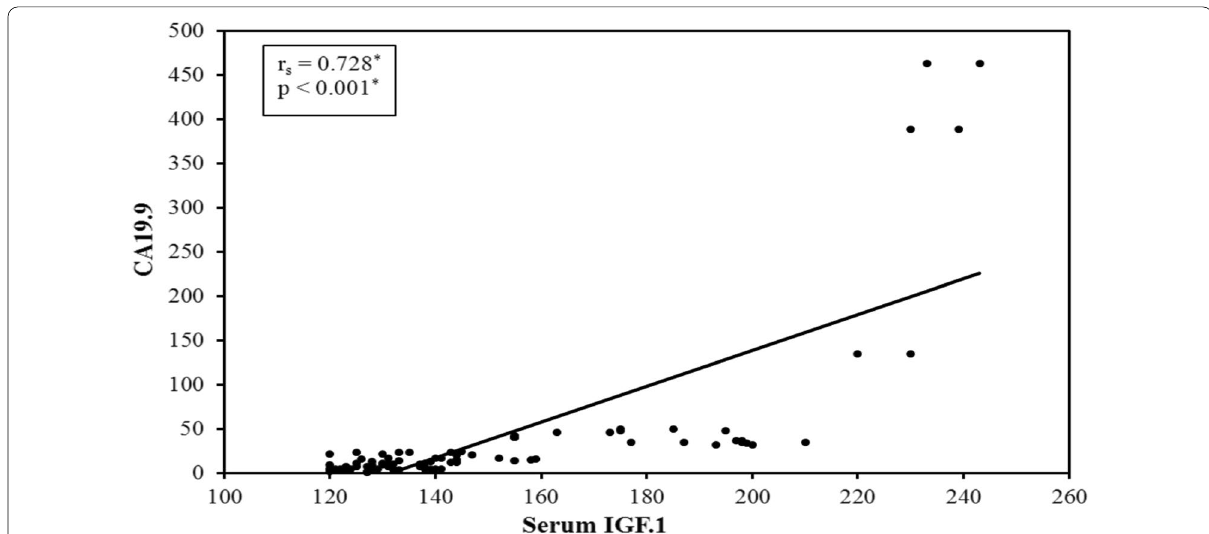
Fig. 5 Correlation between IGF rs6214 with CA19.9 in colorectal cancer group ( n